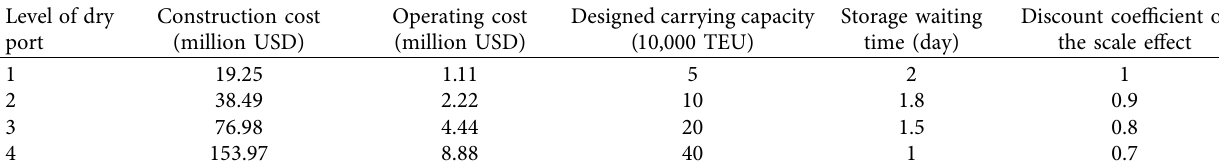
Table 7: Classification of dry port